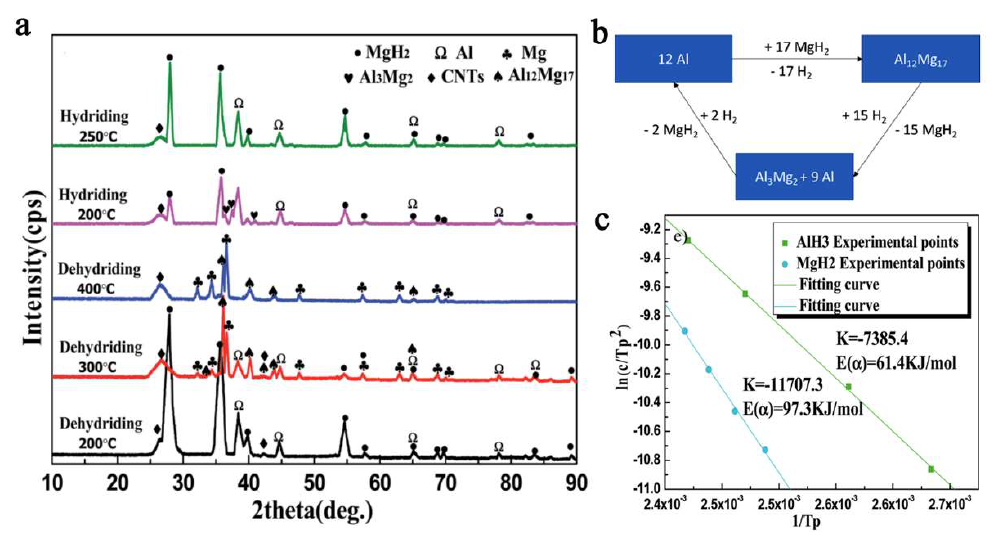
Figure 16. XRD pattern for 95%- 2.5MgH 2 /AlH 3 /CNTs4 after dehydrogenation at temperatures 200…400 °C ( a ); Al-tracking throughout the proposed mechanism, based on reaction data from ref. [109] ( b ) and Kissinger plot for deduction of E a for hydrogenation of MgH 2 and AlH 3 ( c ) [109]. Reprinted/adapted with permission from Ref. [109]. 2021, Royal Society of Chemistry.